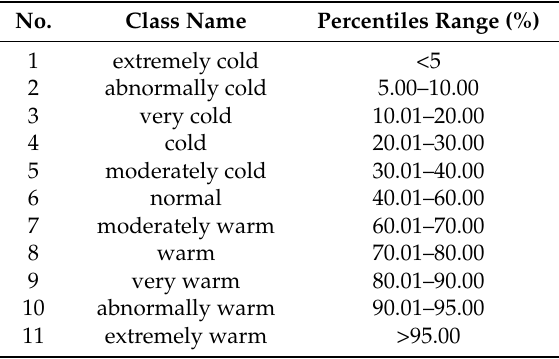
Table 2. Monthly and seasonal criteria for quantile thermal air classification according to Mi˛etus et al.